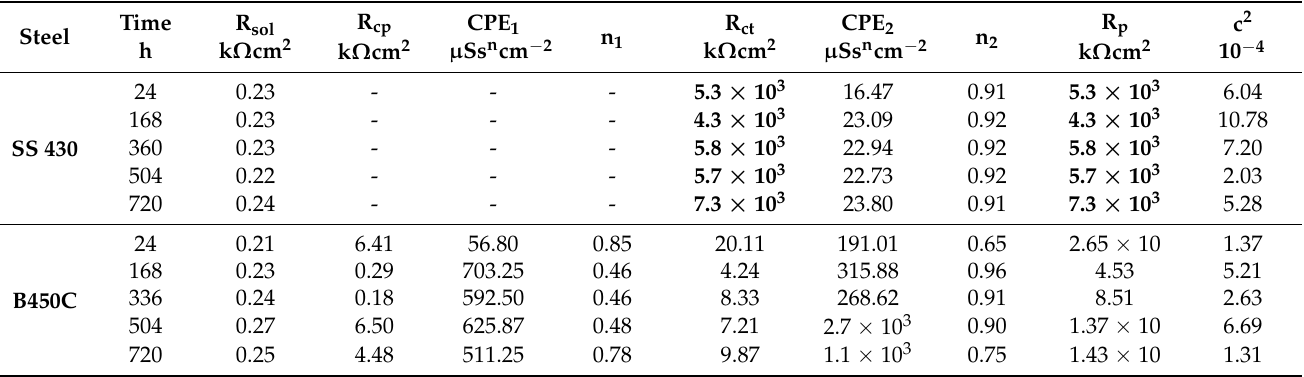
Table 8. Fitting parameters obtained from the EIS measurements for SS 430 and carbon steel B450C exposed to chloride-containing cement extract solution up to 720 h (30